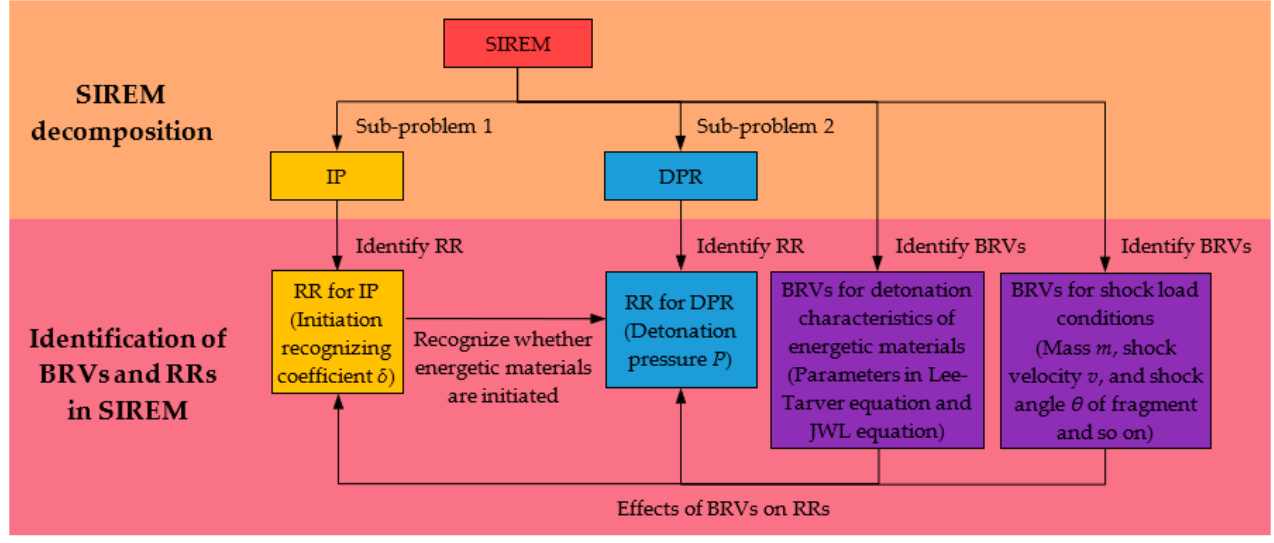
Figure 1. The schema for SIREM.